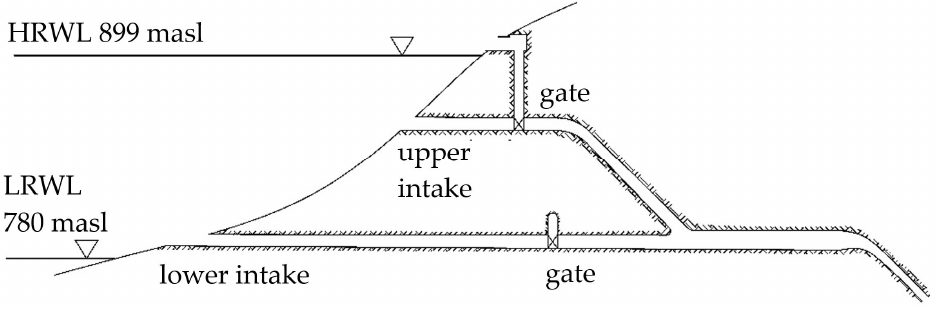
Figure 10. Upstream intakes in Duge PSP.